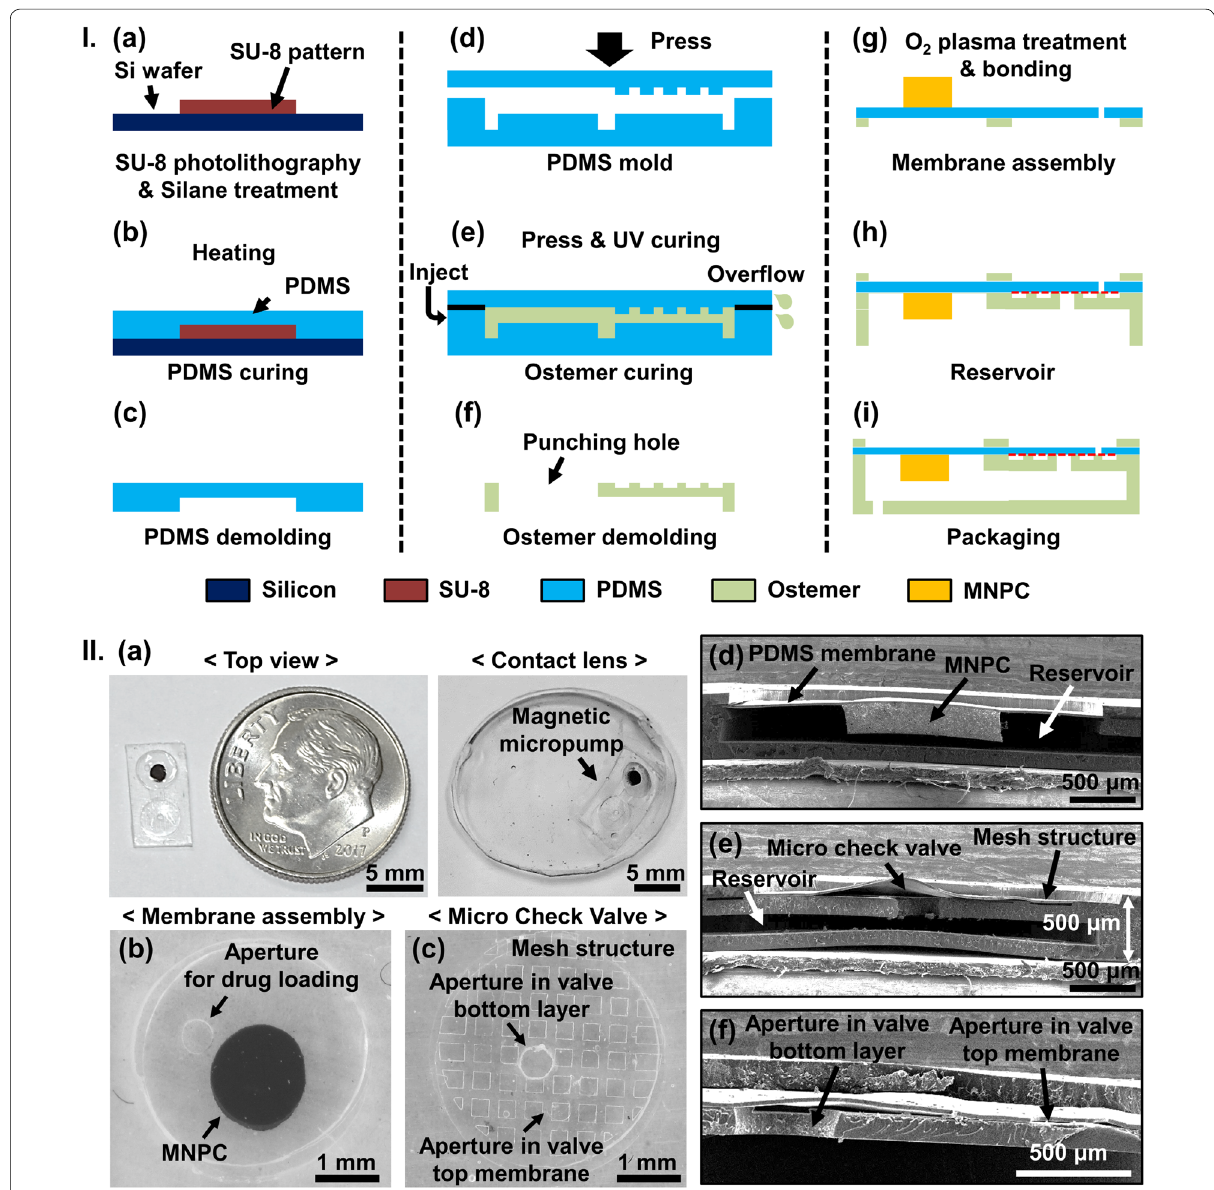
Fig. 2 I The fabrication process of the proposed magnetic micropump: a – c the PDMS master mold fabrication using the standard photolithographic method, d – f casting the main body of the micropump which is composed of Ostemer 322 using the PDMS master mold, and g i the total assembly of the magnetic micropump through O 2 plasma treatment. The apertures on the PDMS membrane and Ostemer layer − were punched by using biopsy punches. II a The photography of the fabricated micropump and the micropump-integrated contact lens. The microscope image of the top view of b the membrane assembly region and c the micro check valve region. The SEM images of the cross-sectional view of the fabricated magnetic micropump including d the membrane assembly region, e the micro check valve region, and f the apertures in